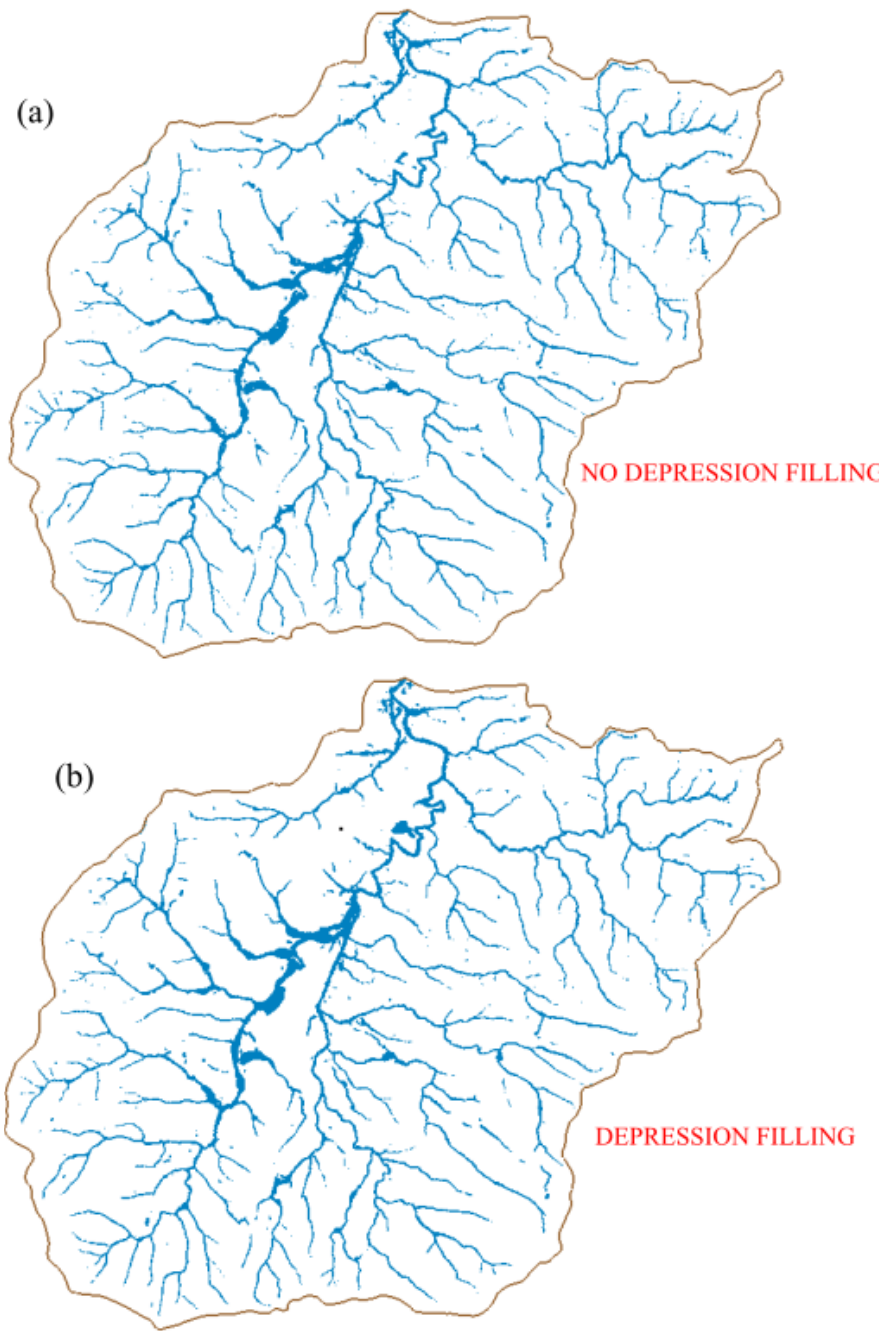
Figure 8. Spadola watershed. Drainage patterns tracked by the rain-on-grid approach using the A*-h s criterion: ( a ) no depression filling and ( b ) depression filling. Table 3. Summary of the values related to IOV and IFR for each simulation.